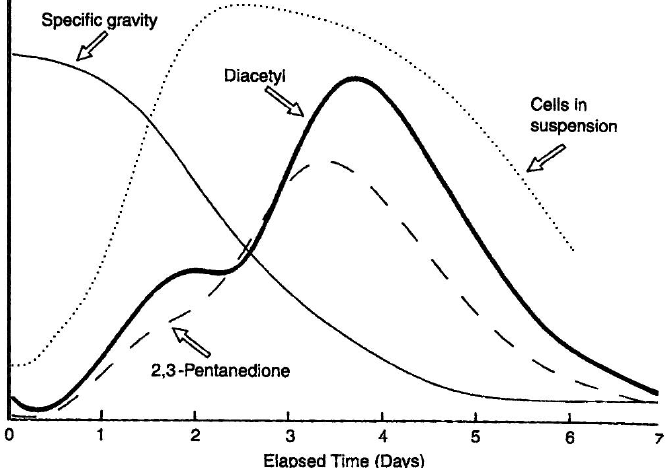
Figure 13. Metabolsim of VDKs during wort fermentation. The figure shows the relationship between diacetyl and 2,3-pentanedione, yeast cell growth and specific wort gravity